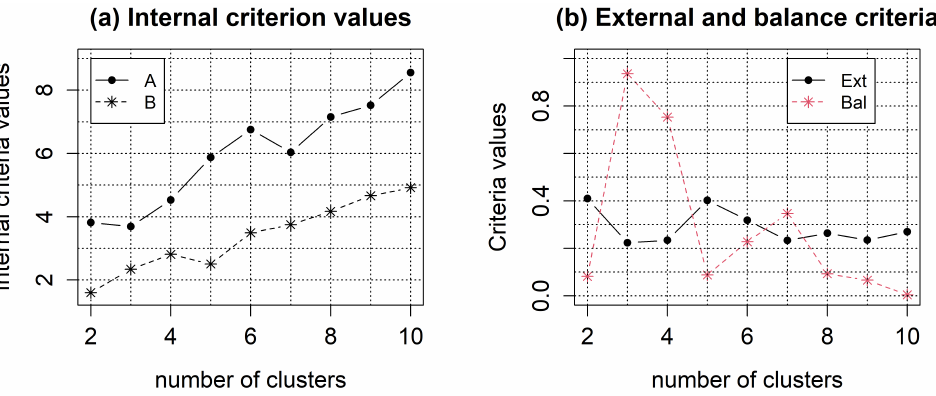
Figure 9. The simulation results regarding the practical implementation of the hierarchical spectral clustering algorithm based on inductive methods of complex systems